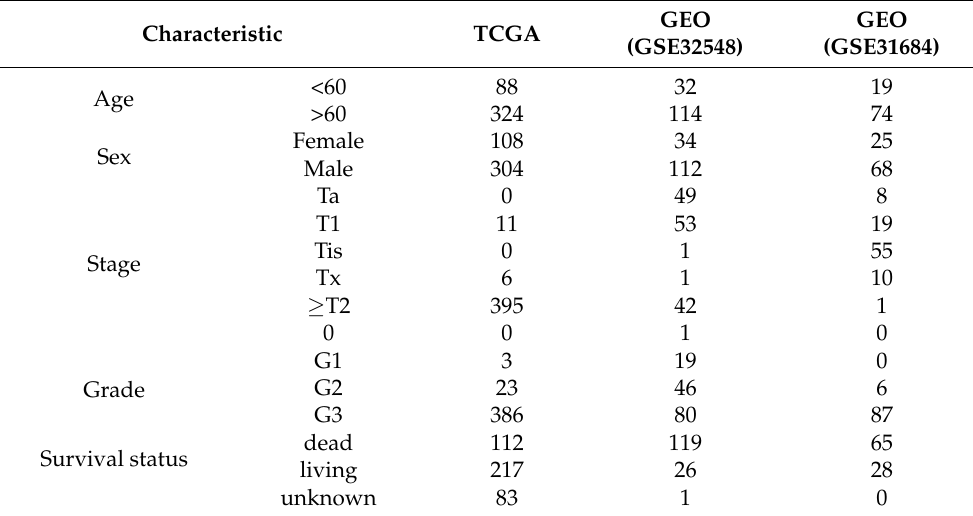
Table 1. Detailed information on patients with BC from the Cancer Genome Atlas (TCGA) and Gene Expression Omnibus (GEO)